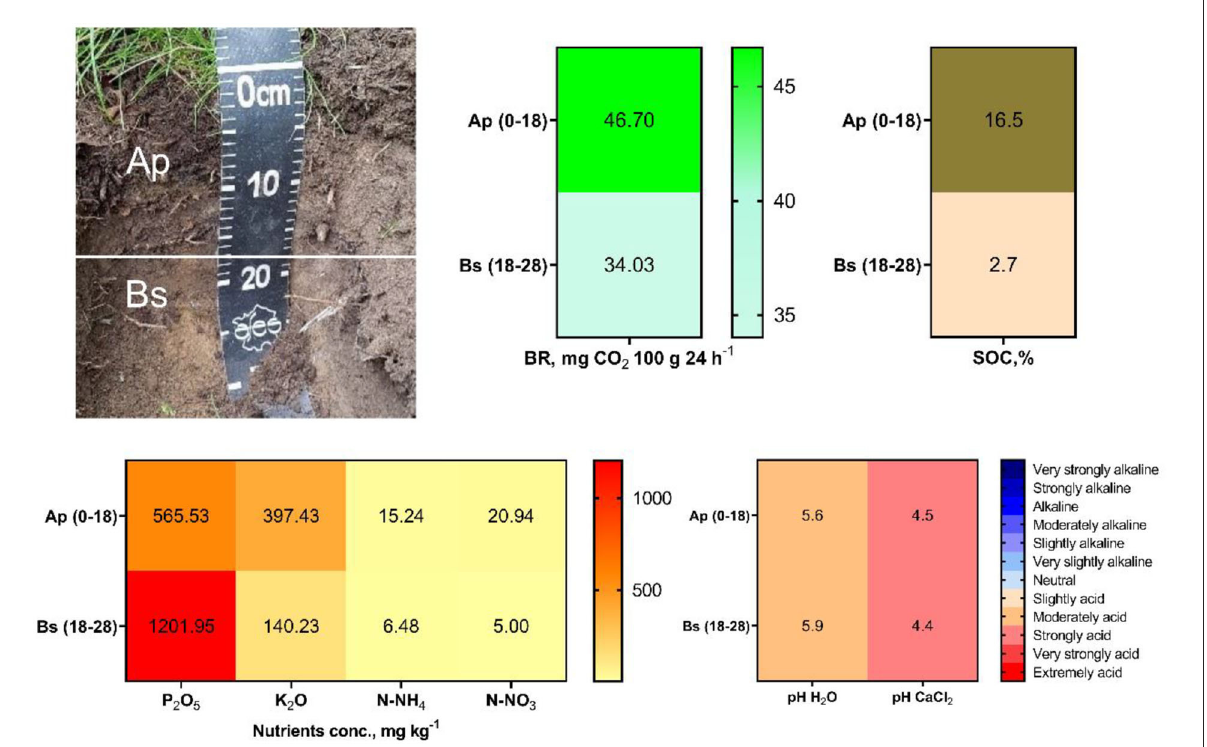
FIGURE11 Main soil properties of abandoned greenhouse in Komi village. Soil name: Hortic Anthrosol (WRB, 2015).